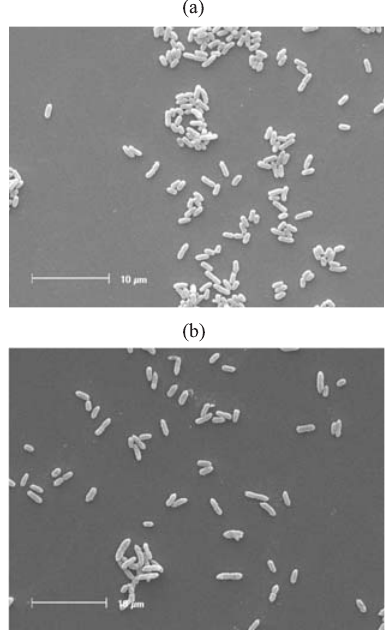
Figure 2. Scanning electron microscopy of vegetative cells of strain RP1p (a) and RP2p (b) shows frequent occurrence in pairs. Bars = 10